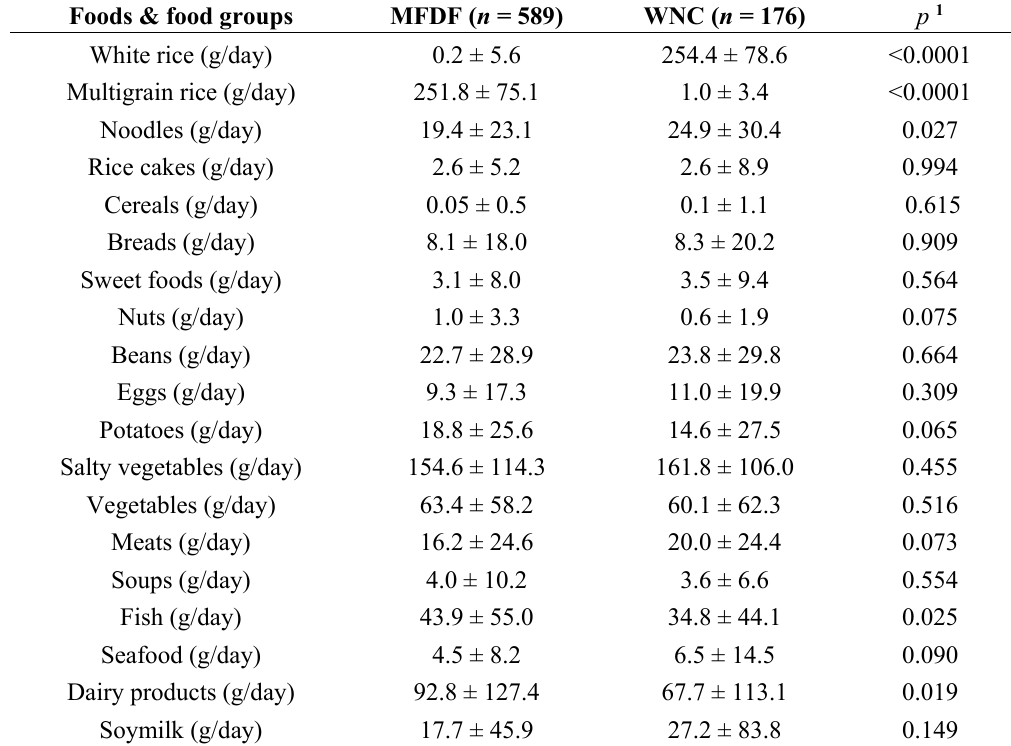
Table 1. Means of food and food groups intakes in the two dietary patterns. Foods & food